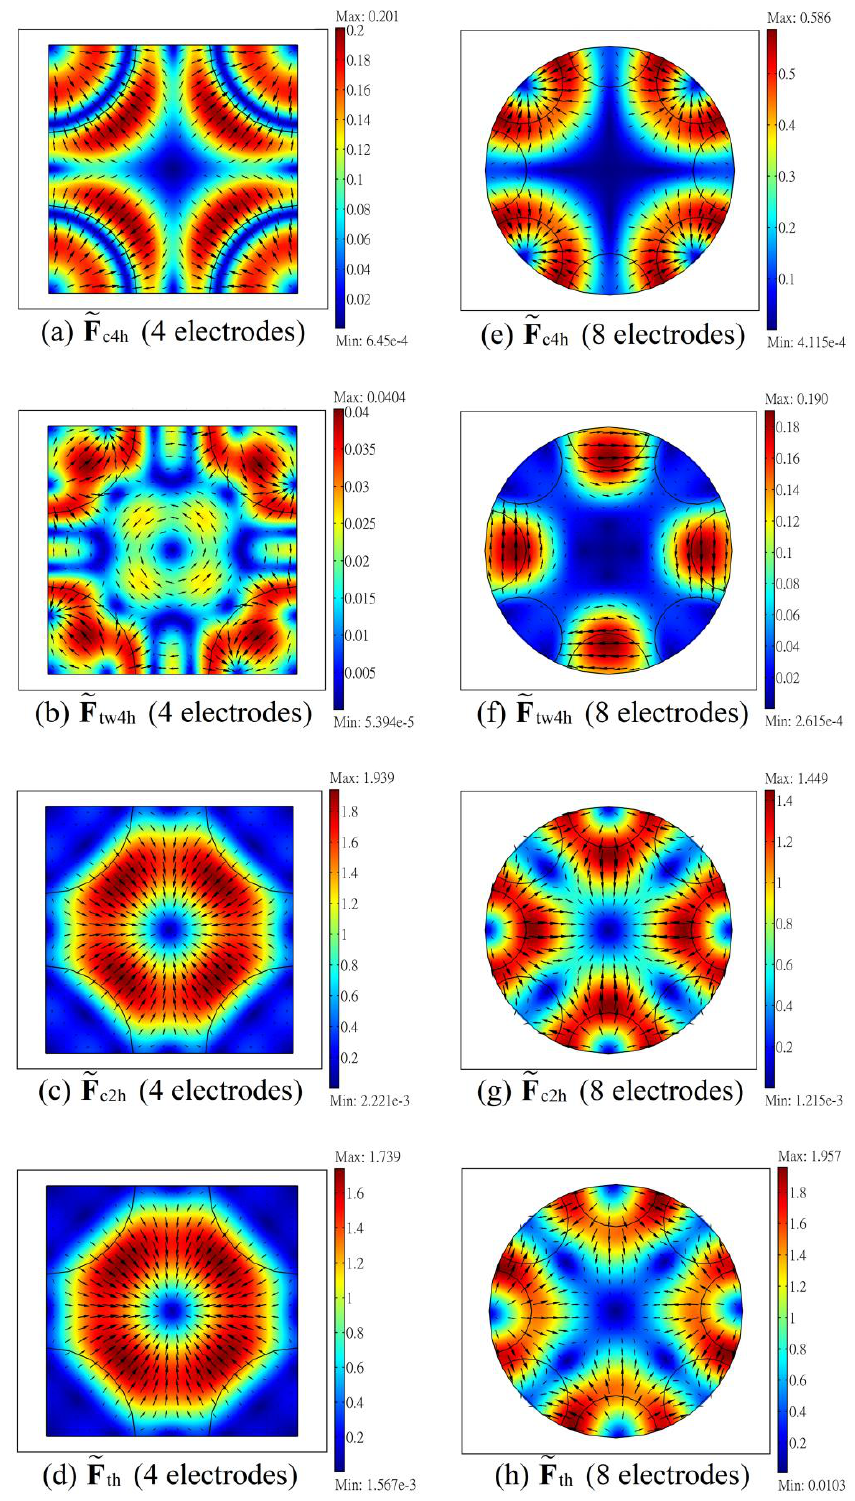
Figure 3. Distributions of dimensionless horizontal forces on the cell on a plane at height 32 µ m in the ER chamber for a typical case under positive DEP. The results are for the case with Colo 205 cell in mannitol solution ( σ m = 0.01 S / m), calculated using V 4 = 1 V, ω 4 = 0.1 MHz, K r4 = 0.4329 and K i4 = 0.254 for the four-phase signal, and V 2 = 2 V, ω 2 = 0.005 MHz and K r2 = − 0.24 for the two-phase signal. ( a–d ) are the results for the 4-electrode system, and ( e–h ) are those for the 8-electrode system. Graphic notations are the same as those in Figure 2.